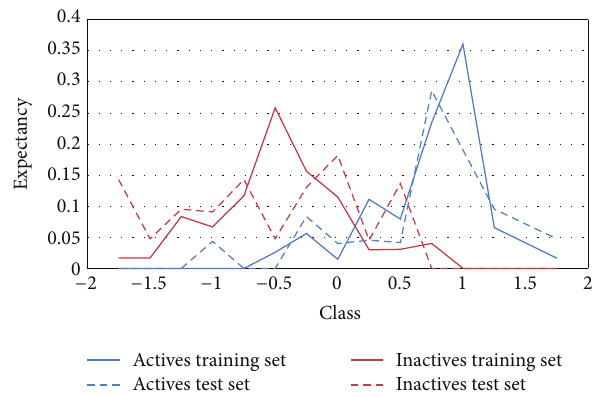
Figure 3: PDD showing the distribution of training and test set active and inactive compounds along the score values of the model. An acceptable superposition between both sets can be observed.